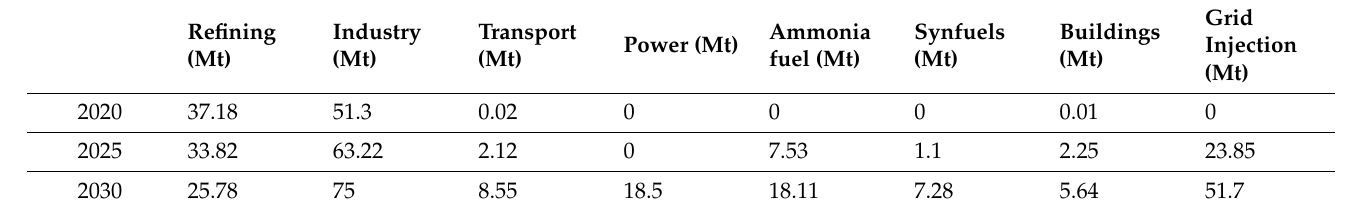
Table 1. Expected global hydrogen demand (in megatons) of the different energy sectors in the Net Zero Scenario, 2020–2030. Reprinted with permission [4,5].